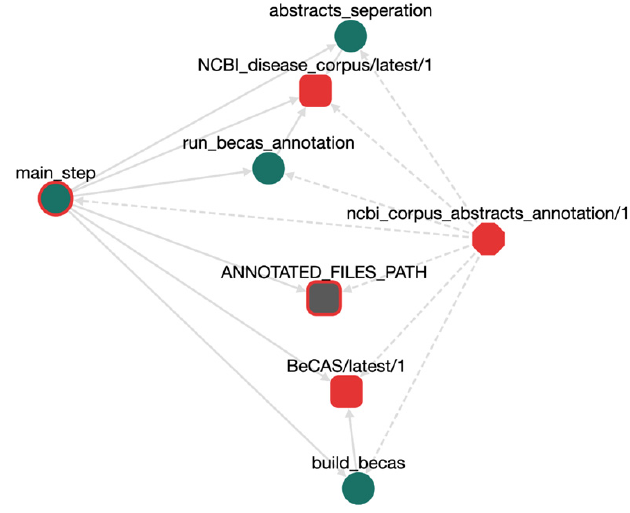
Figure 2. An example workflow in OpenBio.eu for annotating the NCBI disease corpus with the BeCAS annotation tool.